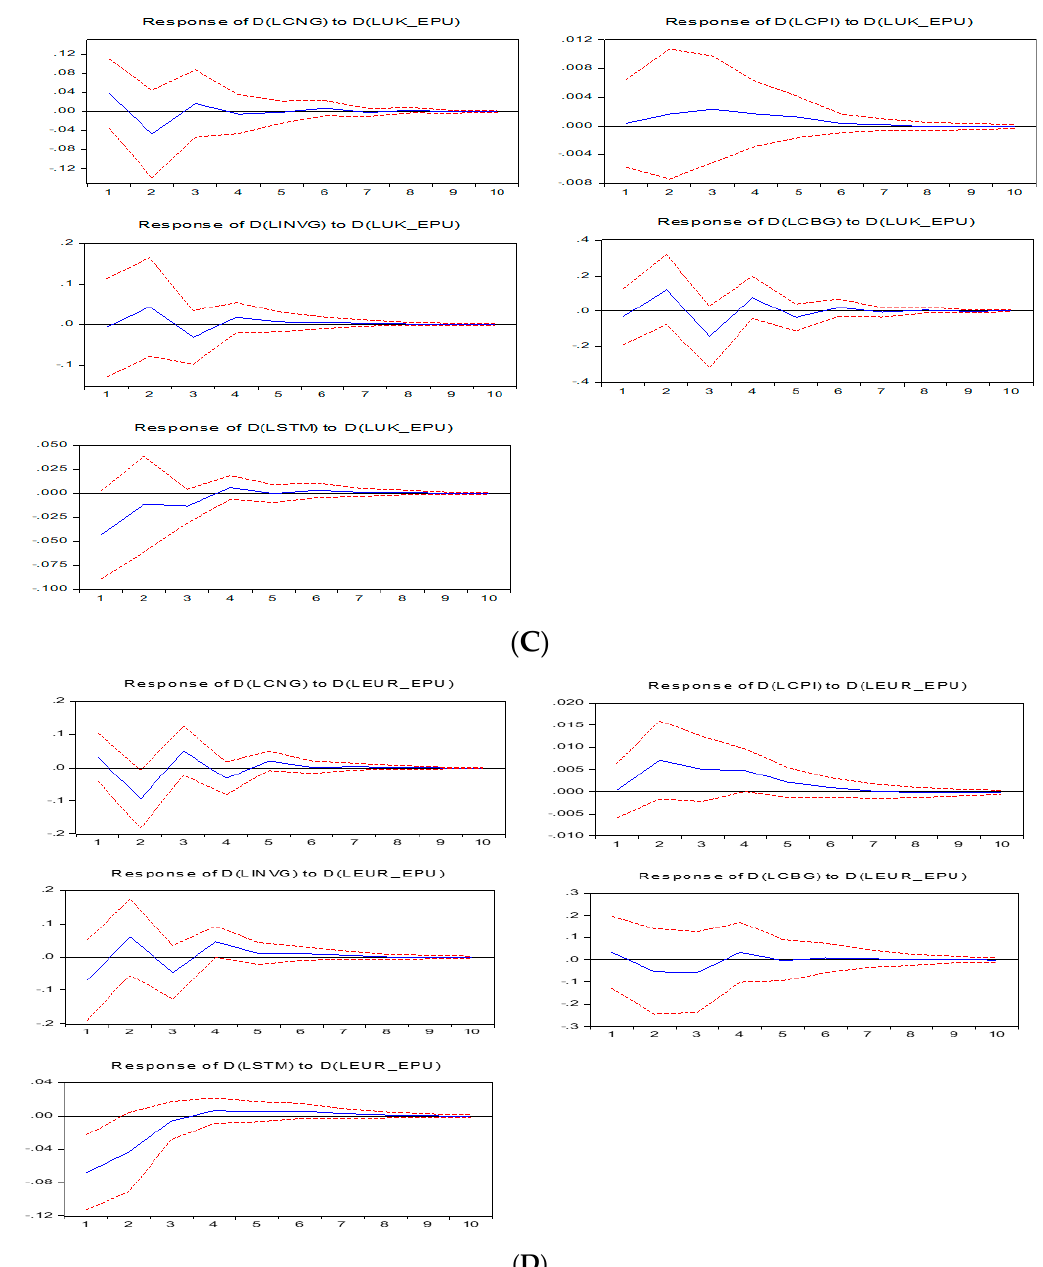
Figure 4. Shows the ( A ) Impact of Domestic EPU on Russia. Note: It shows the impulse response function of consumption, inflation, investment, credit growth and stock market to a Cholesky one standard deviation Domestic EPU context of Russia. Whereas, the two outer lines are Monte Carlo constructed 95% confidence interval. ( B ) Impact of US EPU on Russia. Note: It shows the impulse response function of consumption, inflation, investment, credit growth and stock market to a Cholesky one standard deviation foreign EPU i.e., USA in context of Russia. Whereas, the two outer lines are Monte Carlo constructed 95% confidence interval. ( C ) Impact of UK EPU on Russia. Note: It shows the impulse response function of consumption, inflation, investment, credit growth and stock market to a Cholesky one standard deviation foreign EPU i.e., UK in context of Russia. Whereas, the two outer lines are Monte Carlo constructed 95% confidence interval. ( D ) Impact of Europe EPU on Russia. Note: It shows the impulse response function of consumption, inflation, investment, credit growth and stock market to a Cholesky one standard deviation foreign EPU i.e., Europe in context of Russia. Whereas, the two outer lines are Monte Carlo constructed 95% confidence interval.